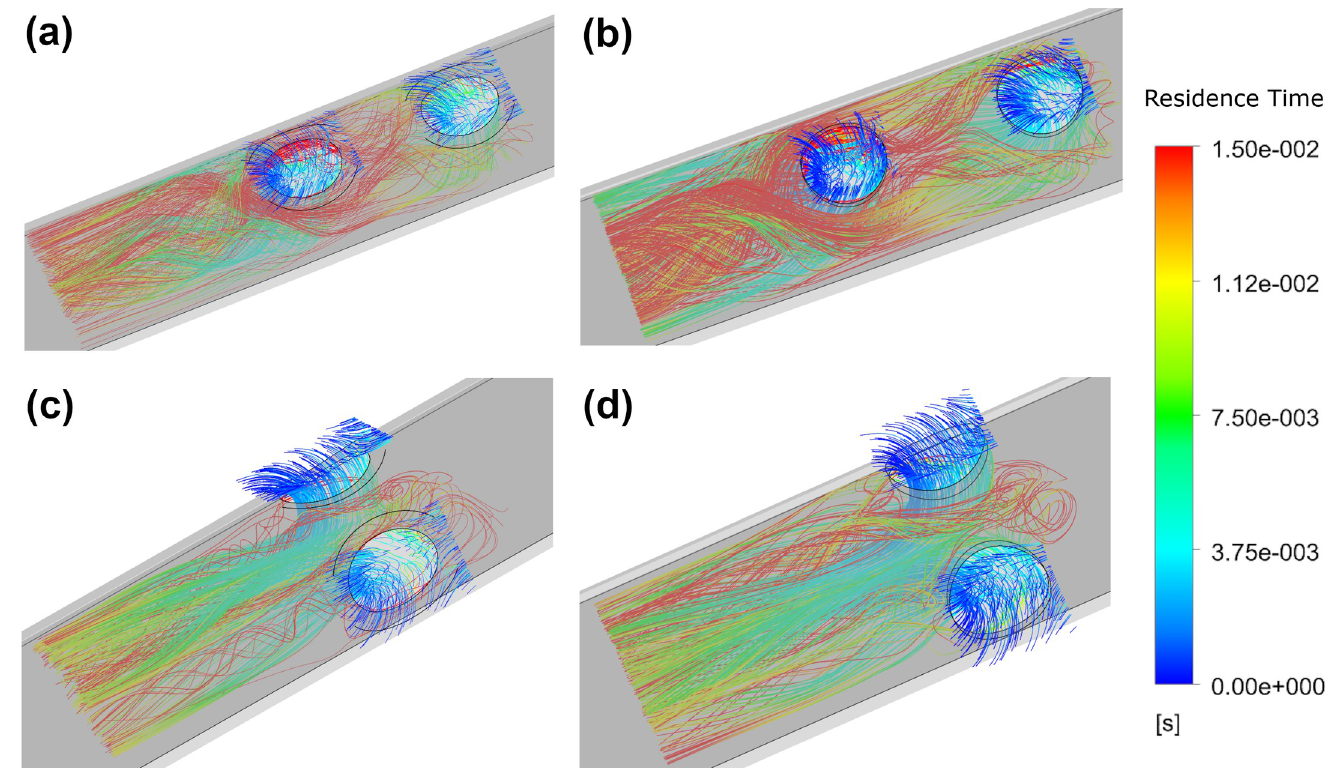
Fig 10. Residence times of inflowing platelets for the: Linear oval (a), Linear circular (b), Parallel oval (c) and Parallel circular (d).